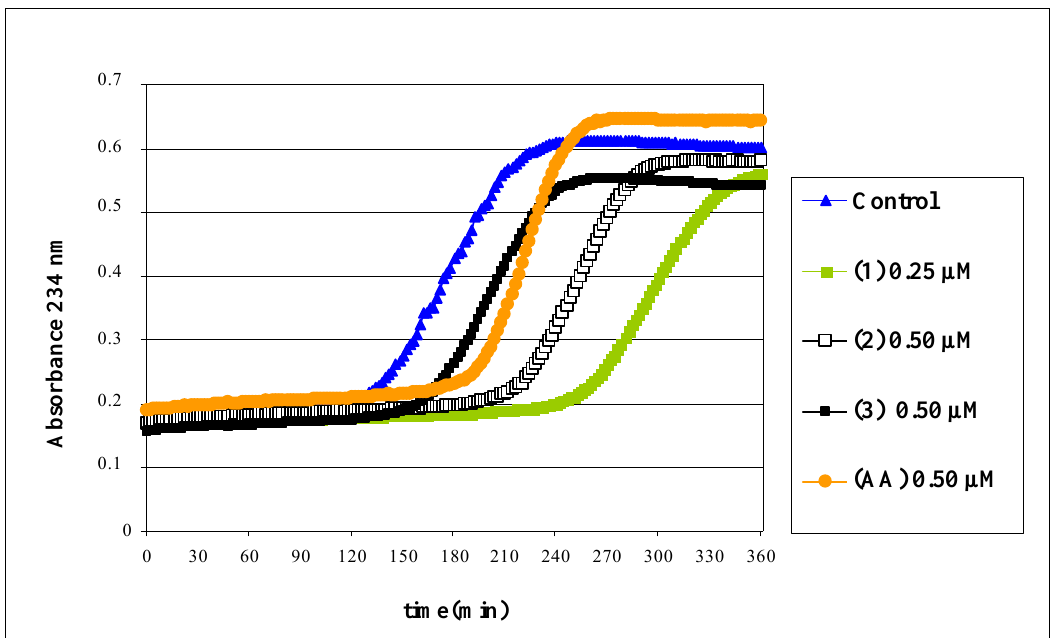
Figure 1. Effects of isoorientin ( 1 ), swertiajaponin ( 2 ) and isoorientin 2"- O -rhamnoside ( 3 ) on copper-mediated LDL oxidation by measuring the increase in absorbance at 234 nm due to the conjugated diene formation AA : Ascorbic acid. The graphic is representative of four separate experiments.